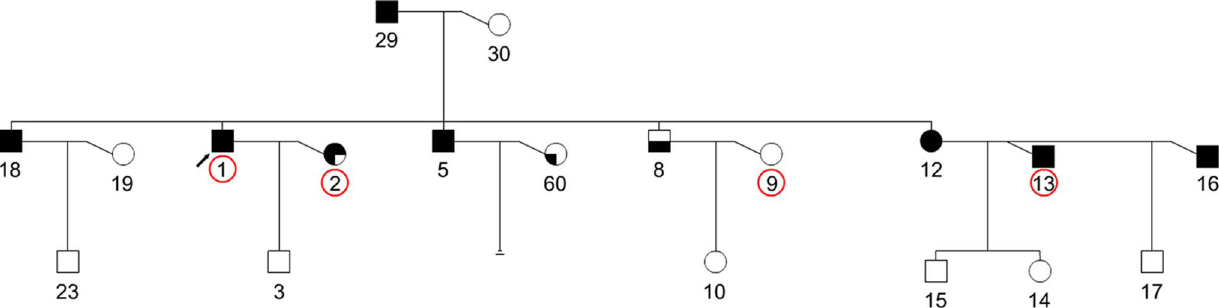
Figure 3. Pedigree of one Map03 family (FAM_ID 20059). Common individuals ( # 1, 2, 9 and 13, from left to right) are genotyped on both microsatellite and SNP markers (circled in red). Box shadowed in upper left: AB, alcohol abuse; shadowed in upper left & right: AD, alcohol dependence (DSM III-R Diagnosis). Box shadowed in lower left: PROB, probable; shadowed in lower left & right: DEF, definite (Feighner Diagnosis). doi:10.1371/journal.pone.0063526.g003 PLOS ONE |